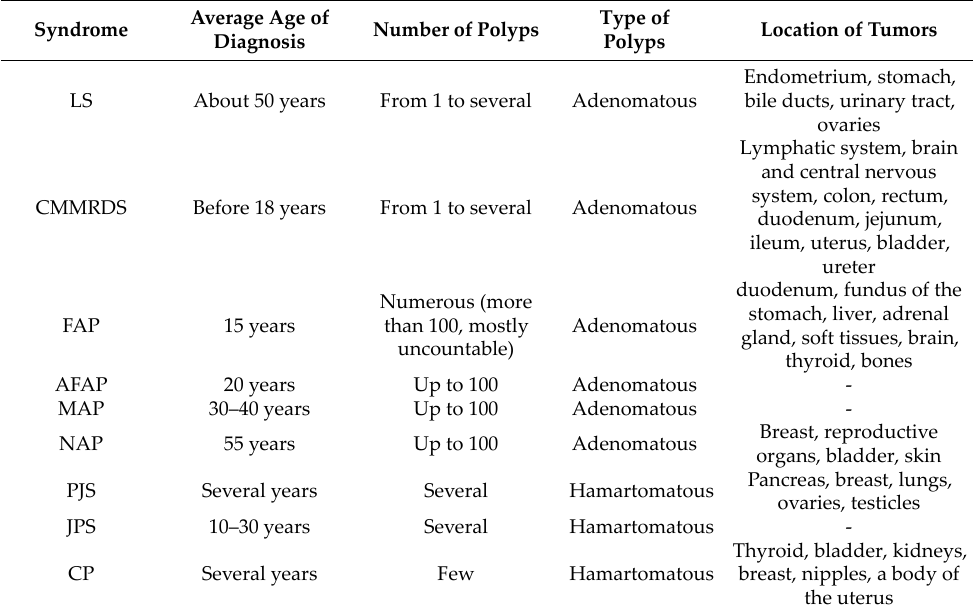
Table 2. Clinical characteristics of syndromes